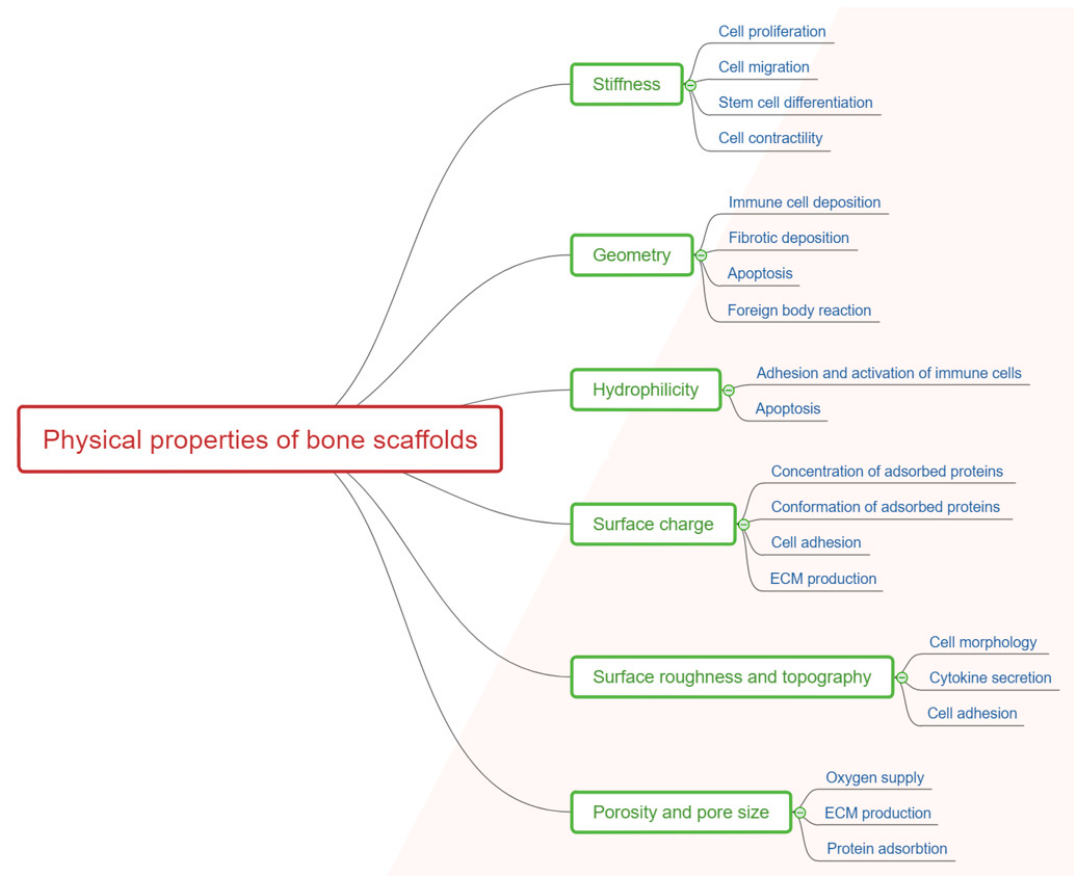
Figure 2. Physical properties of bone scaffolds and their effects on host and bone regeneration. Realized based on [17].